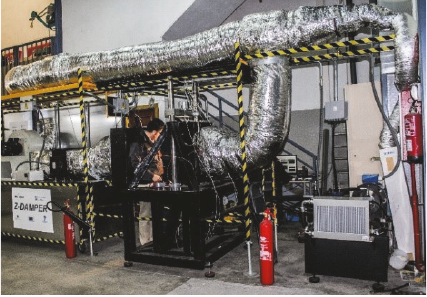
Figure 8: Operating test